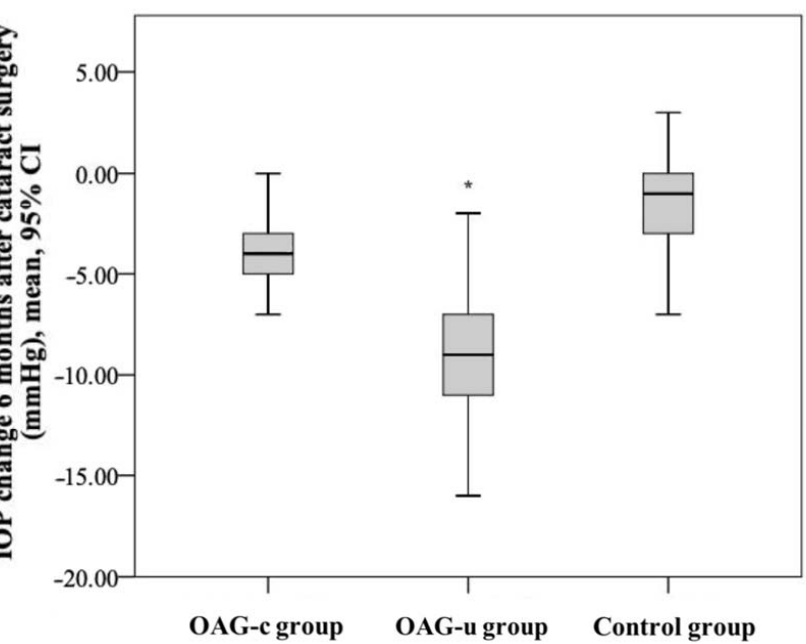
Figure 5. IOP change 6 months after cataract surgery in all groups. The highest negative IOP change was found in the OAG u group (*) ( p = 0.018). A strong negative correlation was found between IOP before cataract surgery and IOP change 6 months after cataract surgery. The higher the IOP before cataract surgery, the higher the negative IOP change 6 months following cataract surgery ( = − 0.706, p < 0.001) (Figure 6).